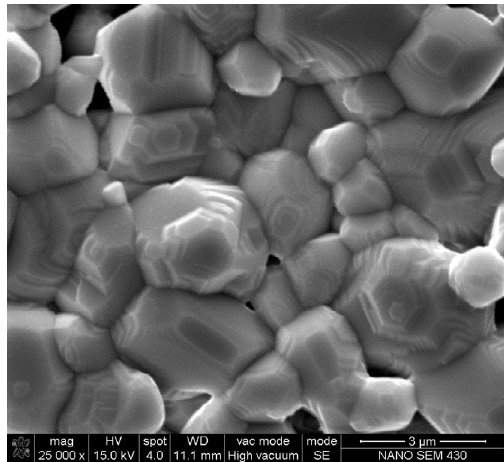
Fig. 9 Variation in microwave dielectric properties containing ε r , Q·f , and τ f